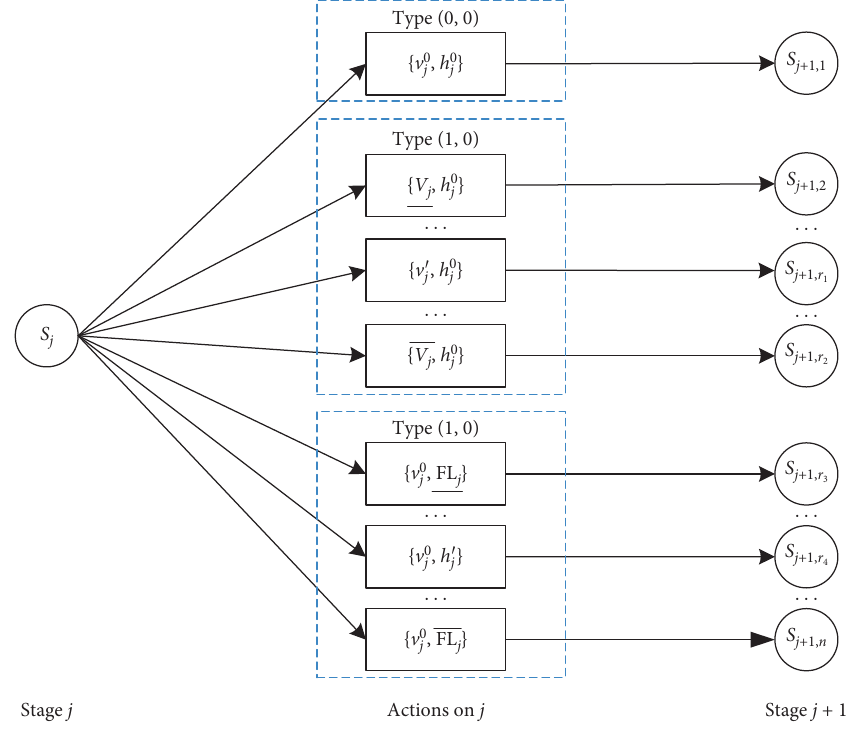
Figure 1: Process of state transition from one stage j to the next stage j +